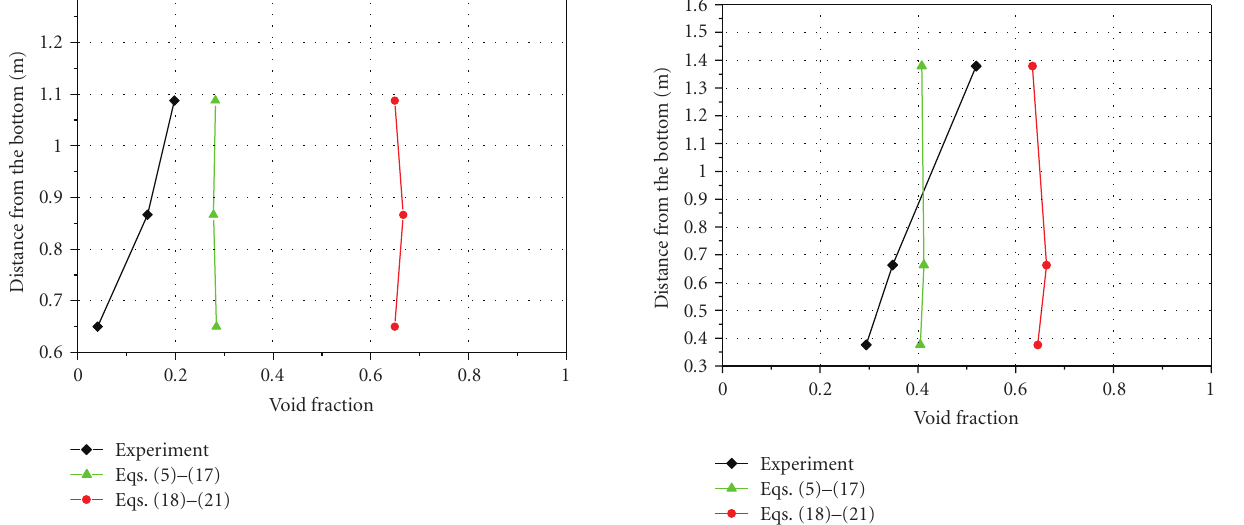
Figure 9: Void fraction profile along the width of the SG model in the area under the SPS in the experiment and in the calculations with the use of the models (5)–(17) and (18)–(21). PGV-1500 [13, 14] were fulfilled with 3D thermal hydraulic code STEG with the use of the interfacial friction correlations (18)–(21) and TRAC interfacial friction correlations